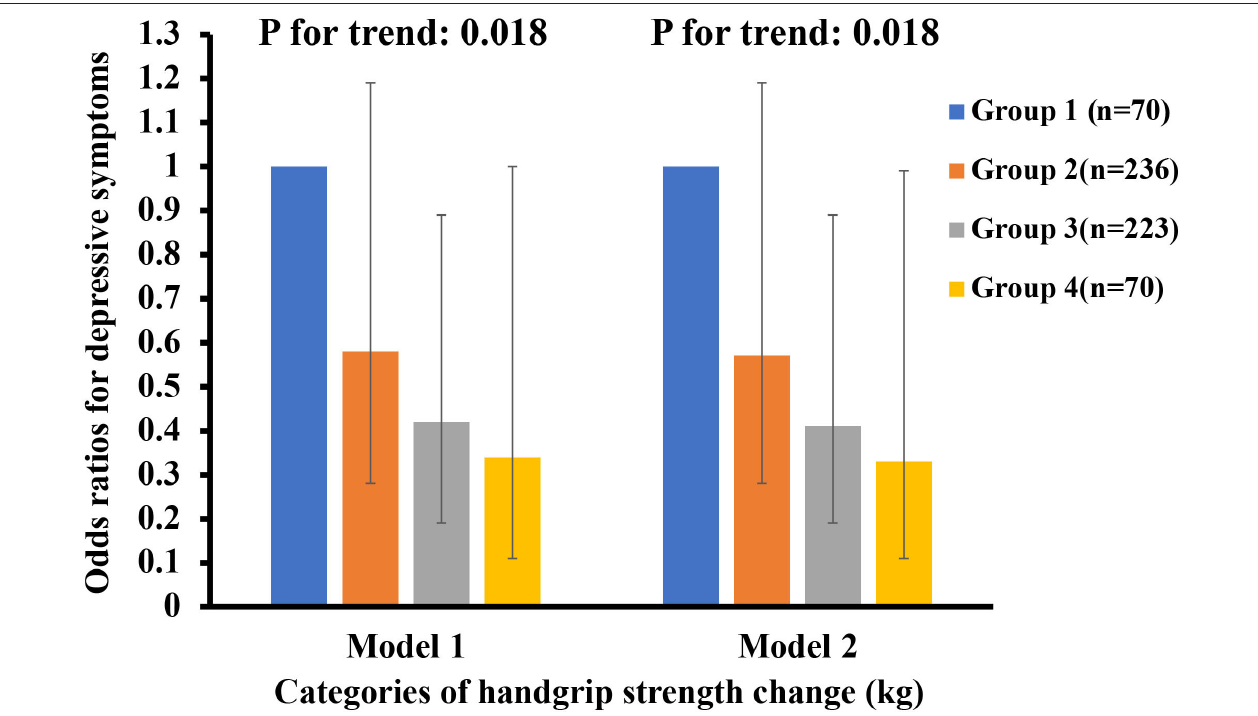
50) ≥ change of smoking status (increase, decrease, no +